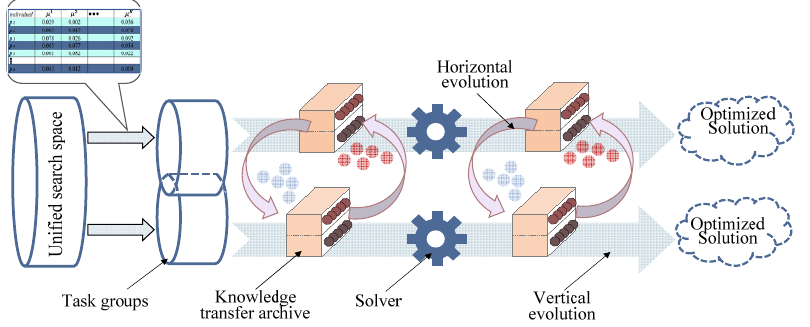
Figure 2. Individually guided multi-task optimization (IMTO) when solving two optimization problems. (1) We divide the optimization process of MTO into vertical and horizontal